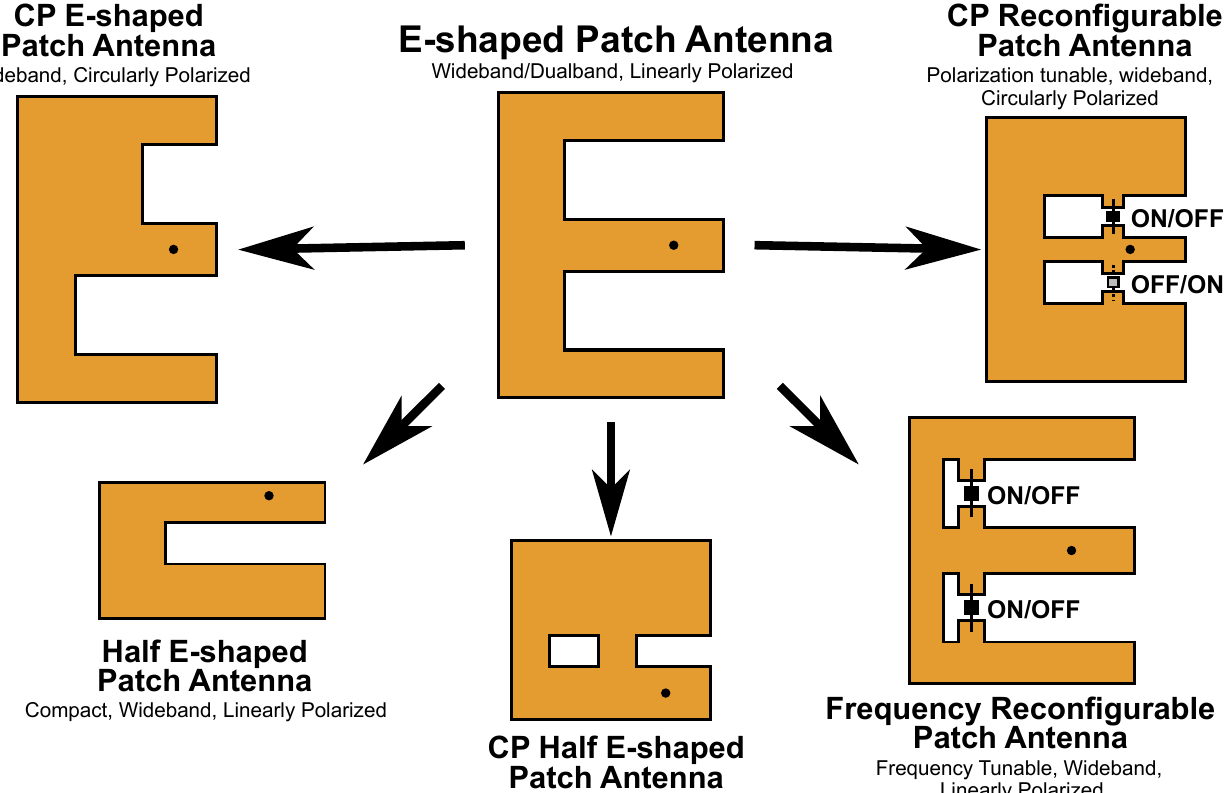
FIGURE 1. This paper focuses on the E-shaped patch antenna, which can be modified to achieve a wide variety of functionalities. This includes circular polarization, miniaturization, and reconfiguration.